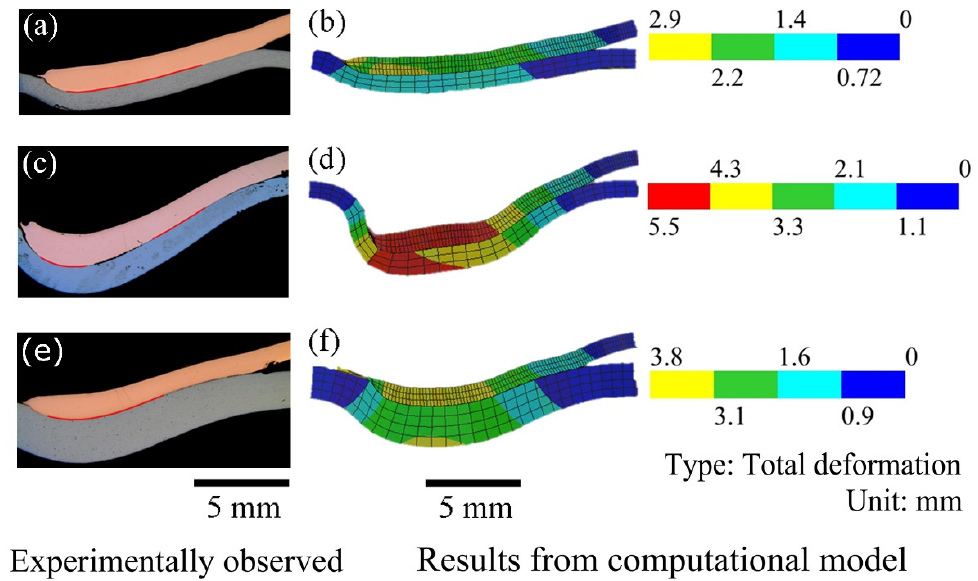
Figure 12. Experimentally observed and computationally estimated flyer-target joint cross-sections with a polyurethane internal support ( a , b ), and without any internal support ( c – f ) for the target tube. (Initial conditions: discharge energy: 16 kJ ( a , b , e , f ), 14 kJ ( c , d ); flyer: diameter = 22.22 mm, wall thicknesses = 0.89 mm; and target: diameter = 18.44 mm, wall thicknesses = 1 mm ( a – d ), 2 mm ( e , f ); standoff distance = 1 mm).